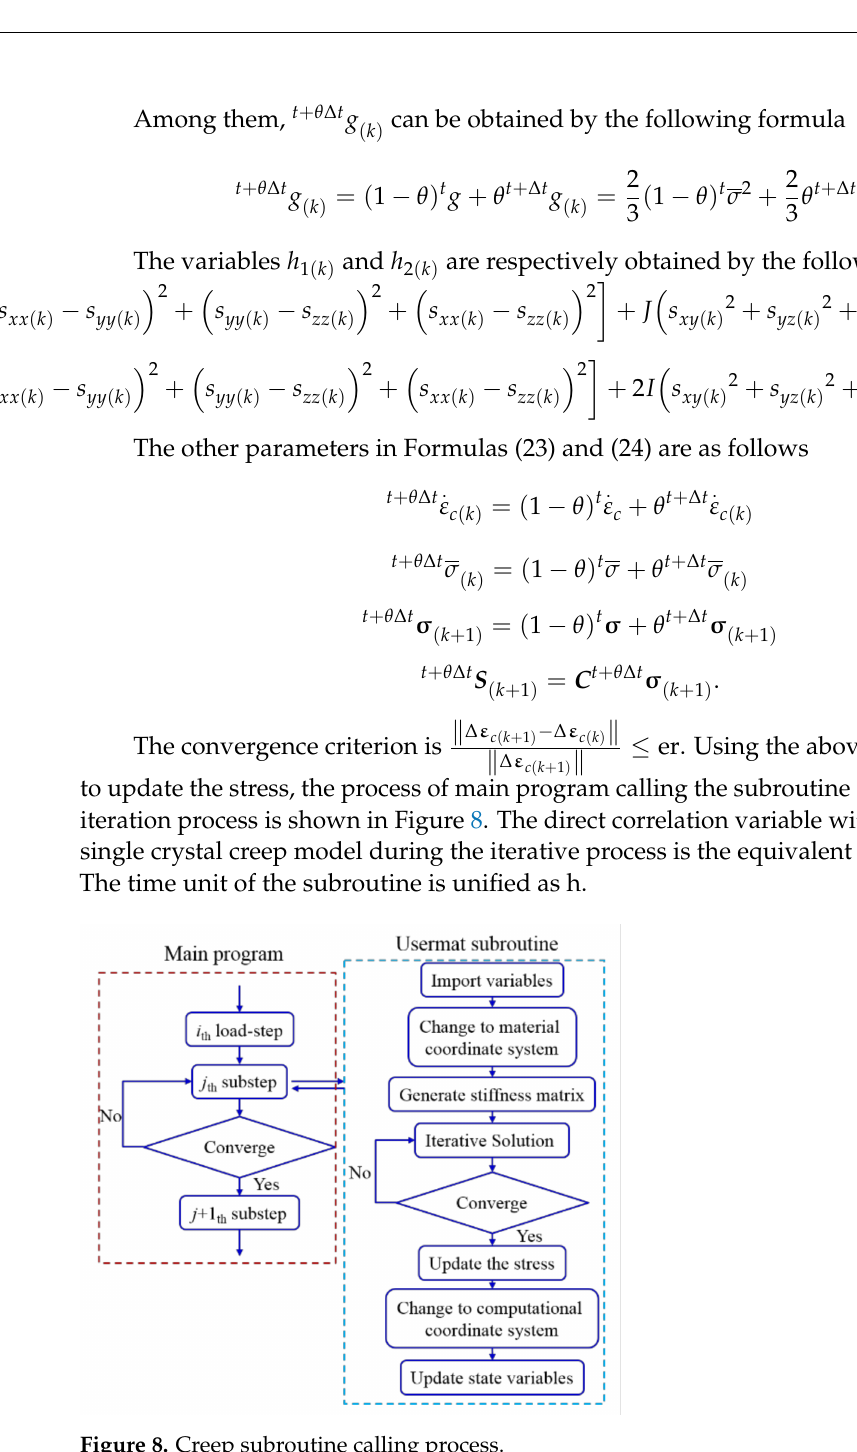
Figure 8. Creep subroutine calling